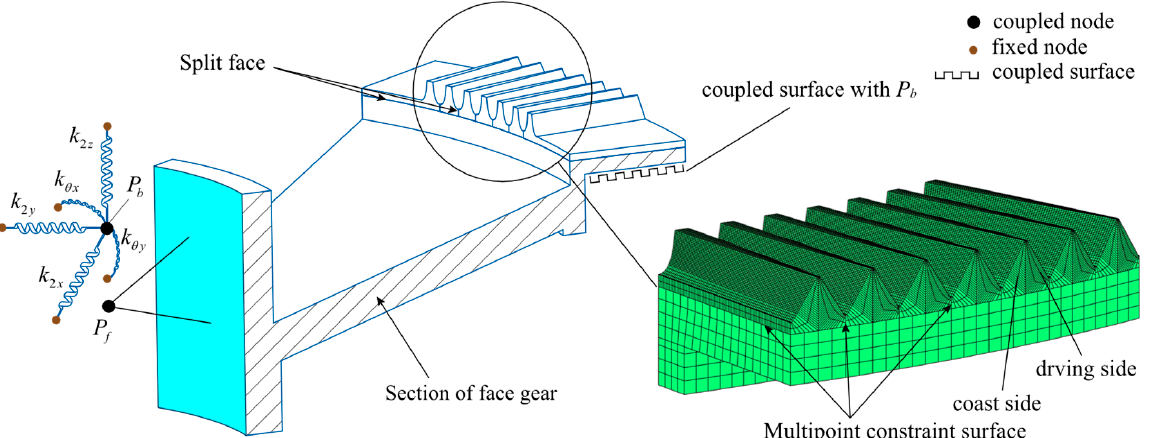
Figure 4. Schematic diagram of the finite element model of the upper face gear.